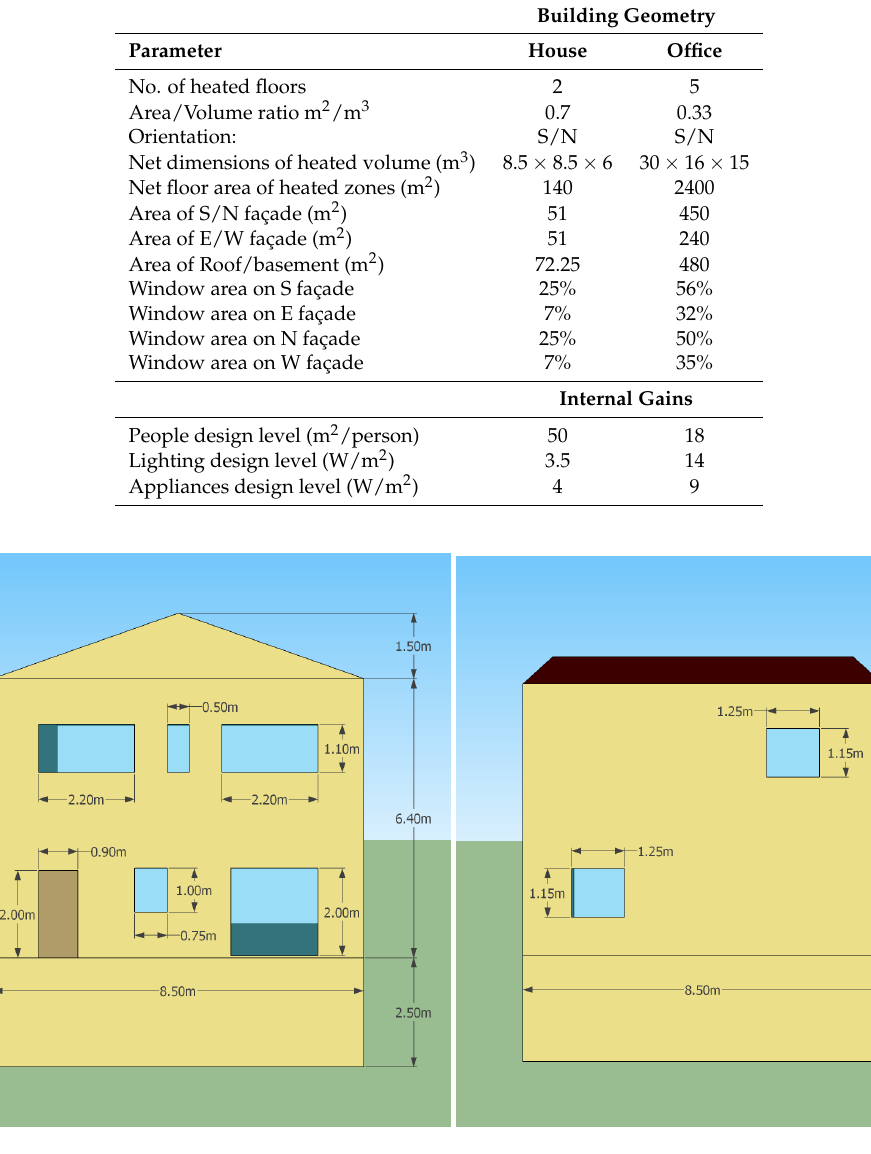
Figure 2. Layout of simplified single family house building design used for the EnergyPlus